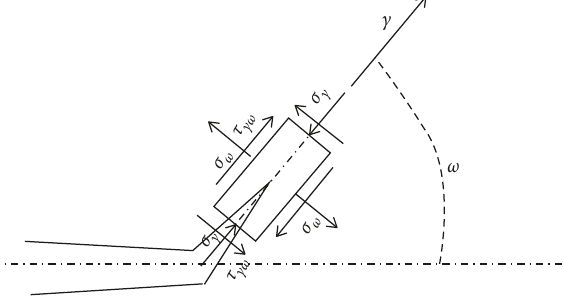
Figure 11: Micro-crack element stress.